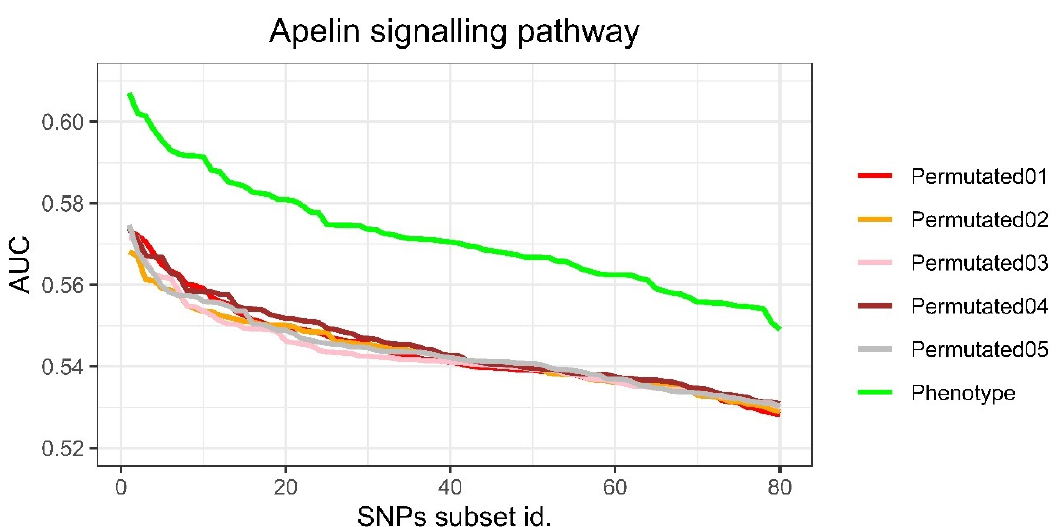
Figure 6. AUC values of the 80 iterations performed for the apelin signaling pathway in the case of cases and controls (phenotype) and five different permutations.